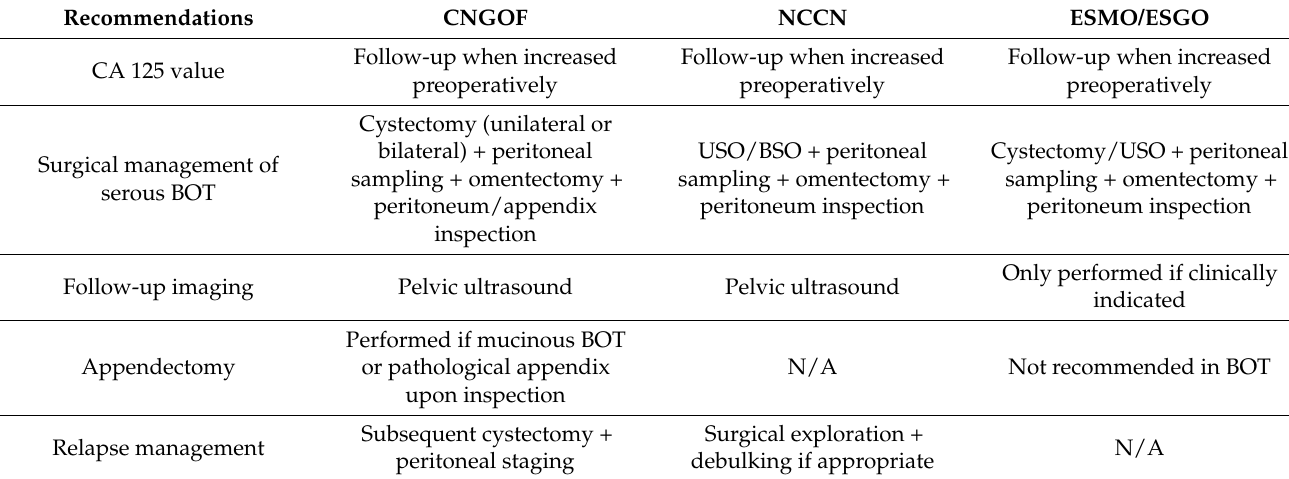
Table 2. Comparison between major guidelines in BOT